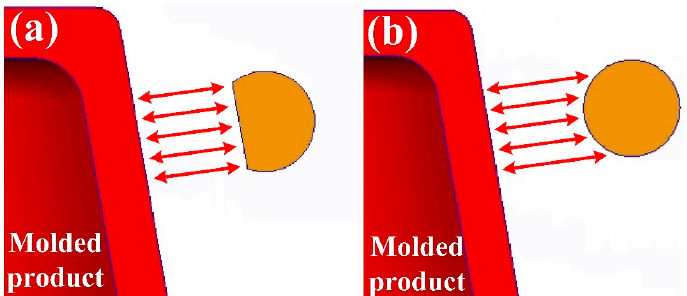
Figure 2. 3D CAD model of the wax pattern.